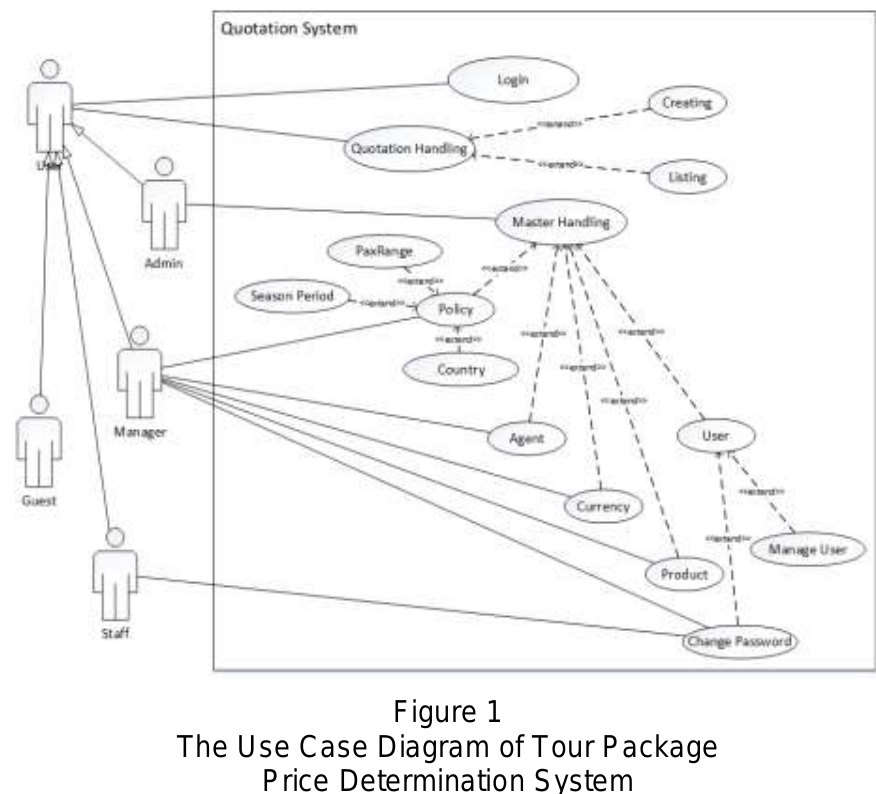
The Use Case Diagram of Tour Package Price Determination